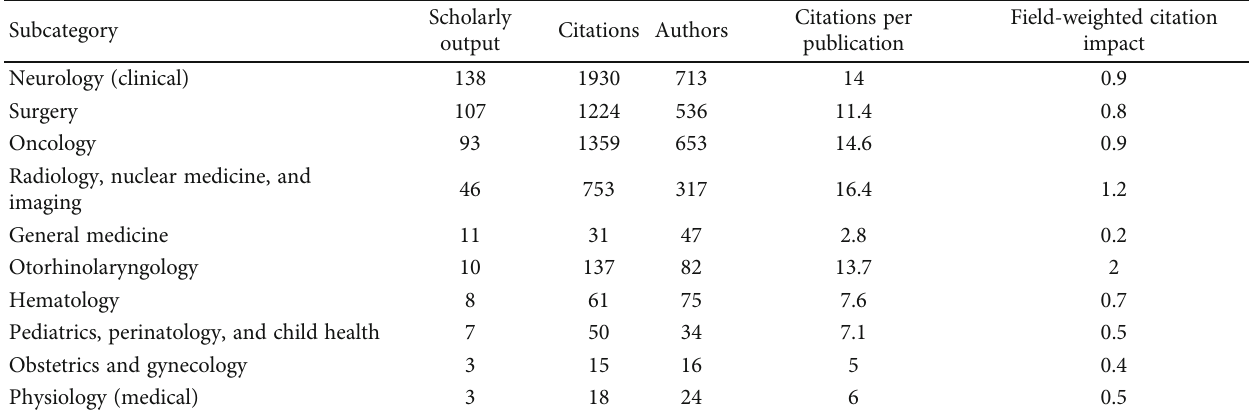
Table 2: Top 10 subcategories by scholarly output of all publication types about knife surgery.